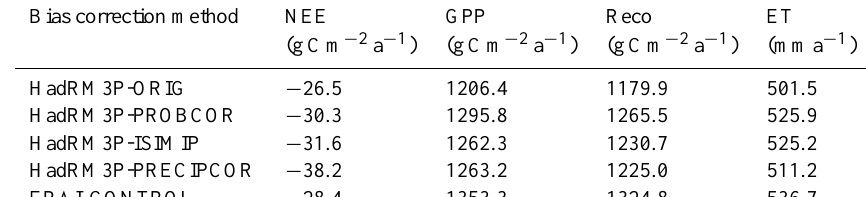
Table 2. Annual mean ecosystem-atmosphere water and carbon fluxes simulated by LPJml over Central Europe.